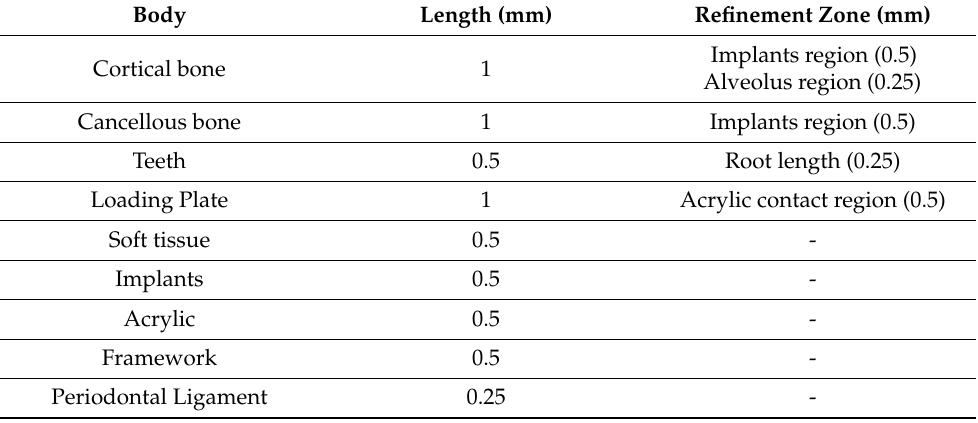
Table 1. Description of the length of element edge attributed to each body and the refinement areas.